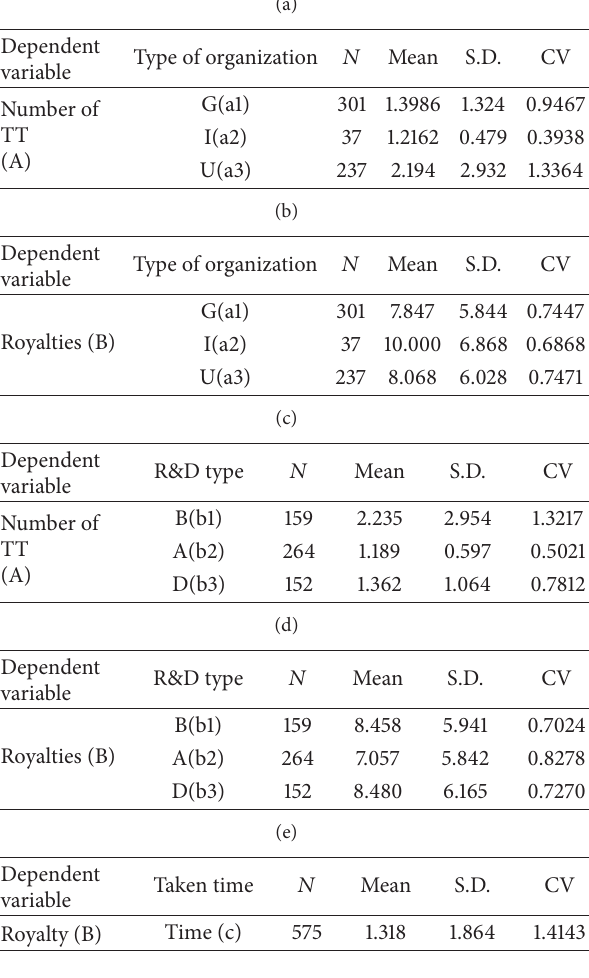
Table 3: The summary of basic statistics.